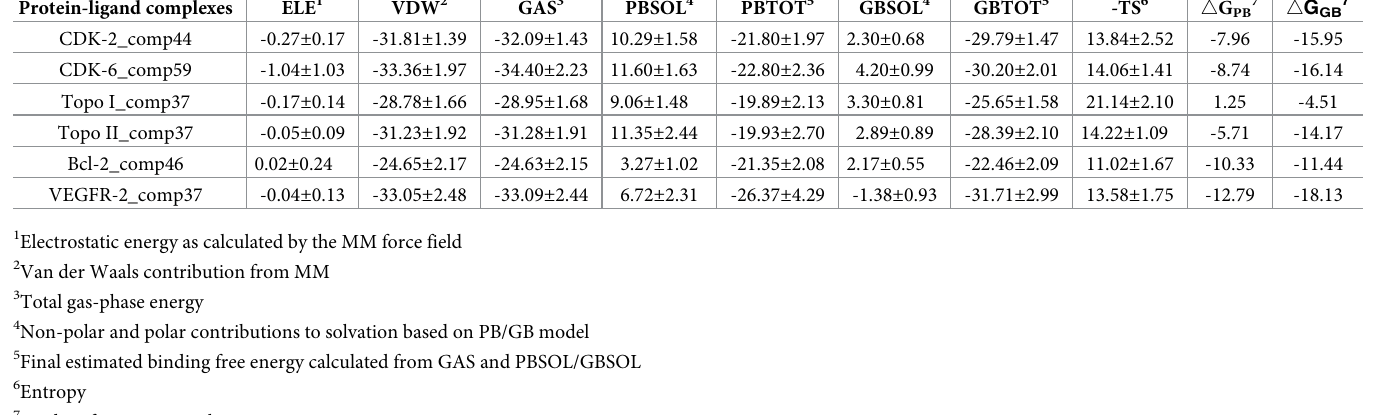
Table 3. Binding free energy calculation of protein-ligand complexes (kcal/mol). Protein-ligand